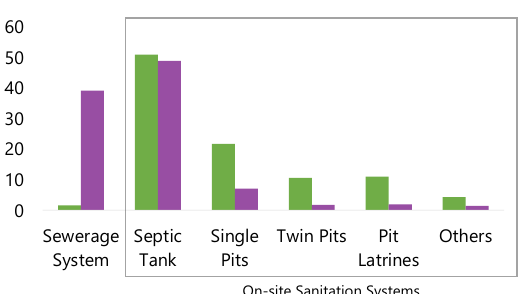
Figure 1. Dependence on different systems for managing